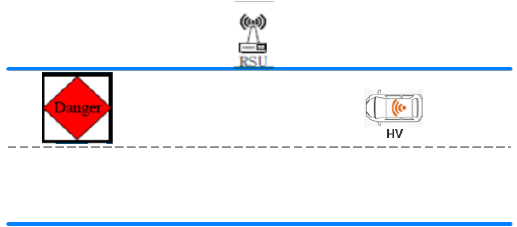
Figure 4. RSU reminds the HV of the danger.